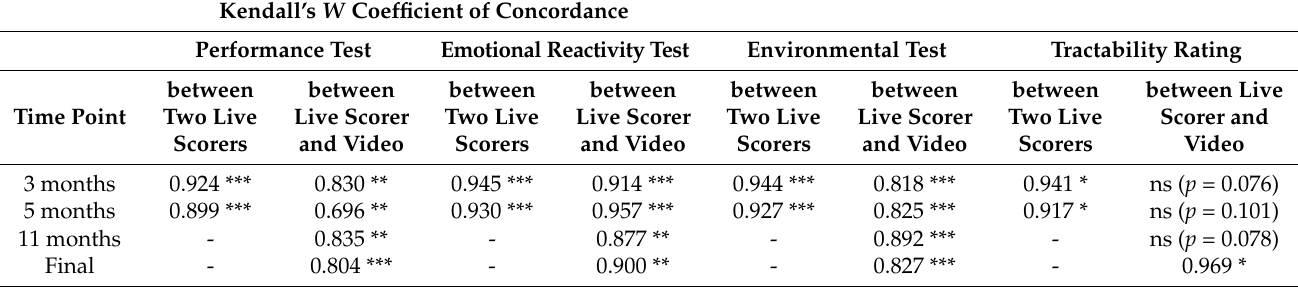
Table 1. Kendall’s coefficients for inter-rater analyses between the primary live scorer and the two secondary scorers. Dashed lines indicate time points in which the second live scorer was not